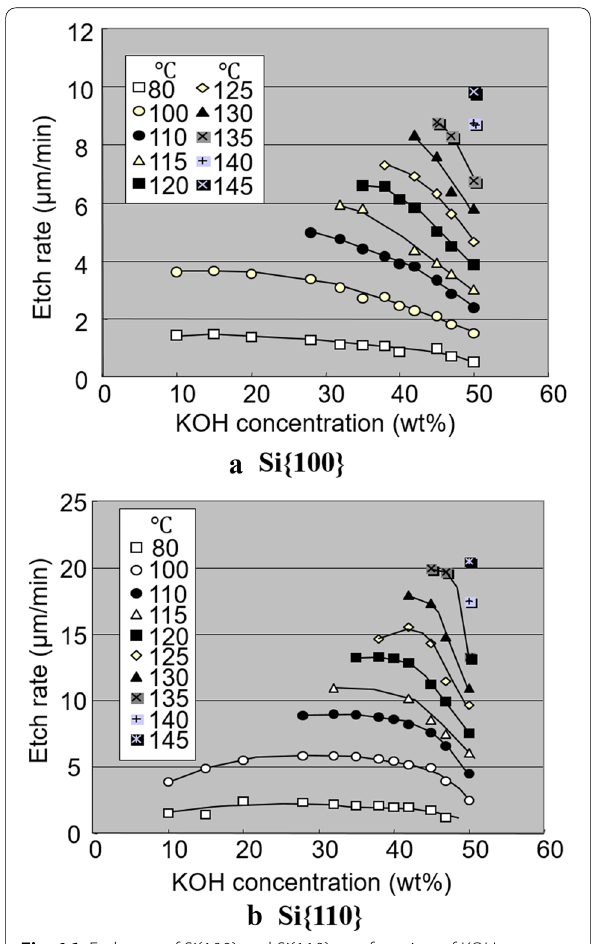
Fig. 16 Etch rate of Si{100} and Si{110} as a function of KOH concentration. Highly concentrated solutions can reach higher temperatures allowing high speed etching [18, 85], © 2004,